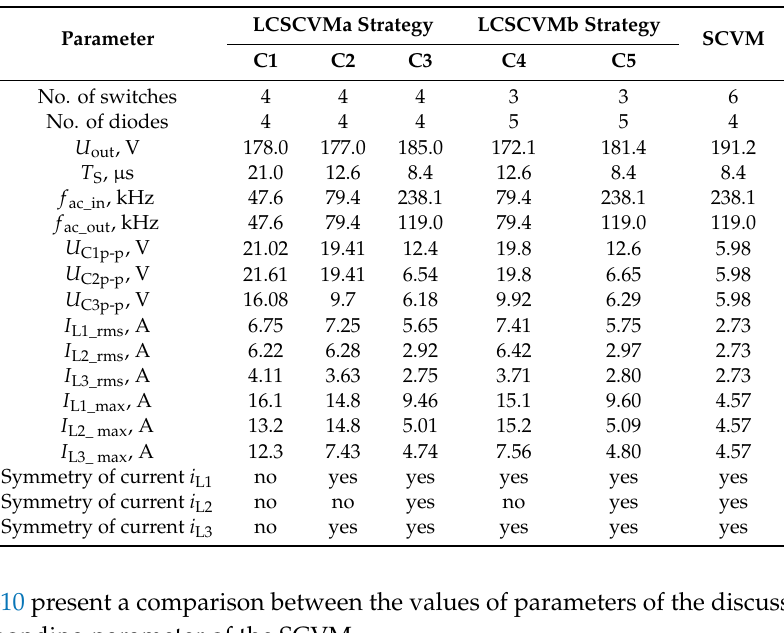
Table 3. Major parameters comparison among the parameters of LCSCVMa and LCSCVMb converters in the tests of 200 W operation.